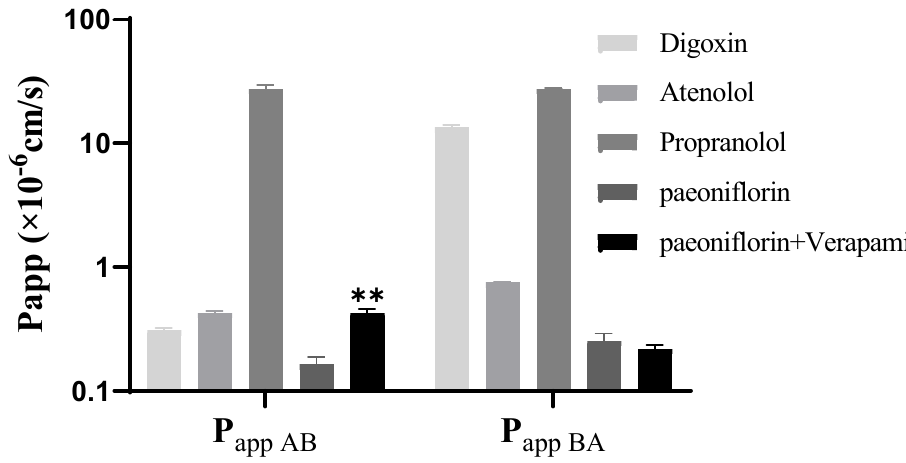
Figure 4. The transport of PF from apical (AP) to basolateral (BL) side and the opposite direction with the treatment of verapamil. Each symbol represents the mean ± SD of two determination. Three quality control samples of atenolol, propranolol and digoxin represented low permeability, high permeability and potential P-gp substrates, respectively.